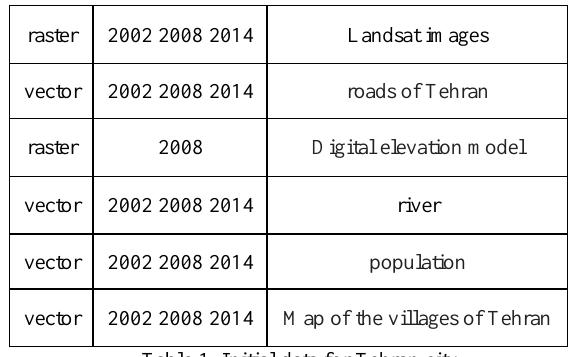
Table 1. Initial data for Tehran city